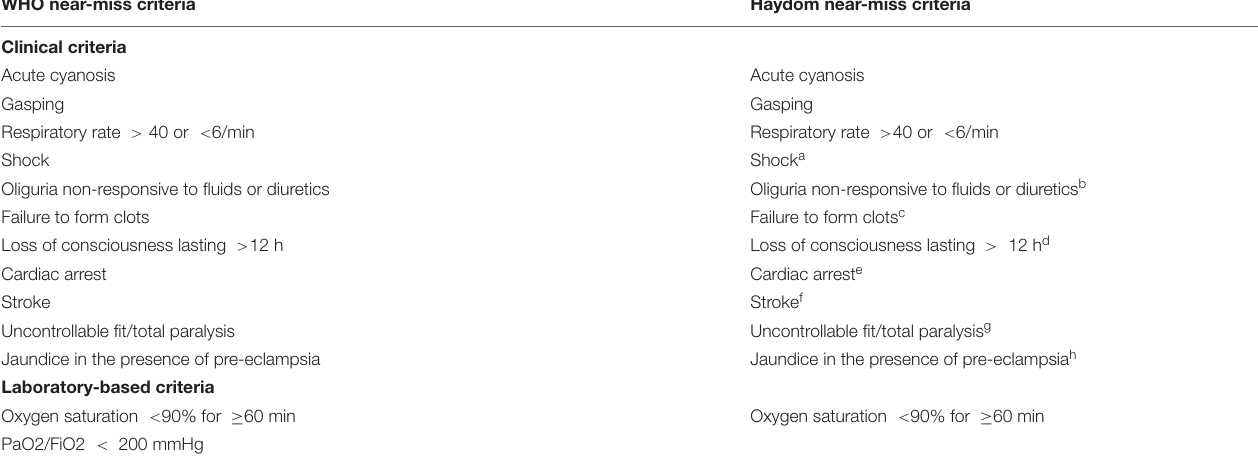
TABLE 1 | WHO maternal near-miss criteria adapted to the local context of low-resource-setting [reproduced from Nelissen et al. (18)]. WHO near-miss criteria Haydom near-miss